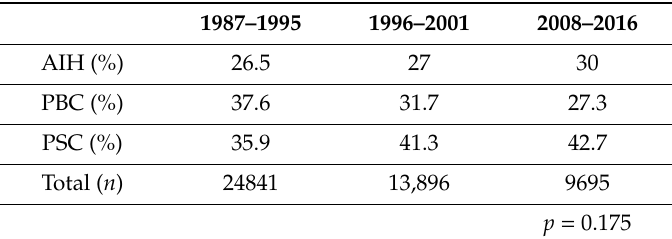
Table 5. Trend in proportion of patients listed over time by autoimmune liver